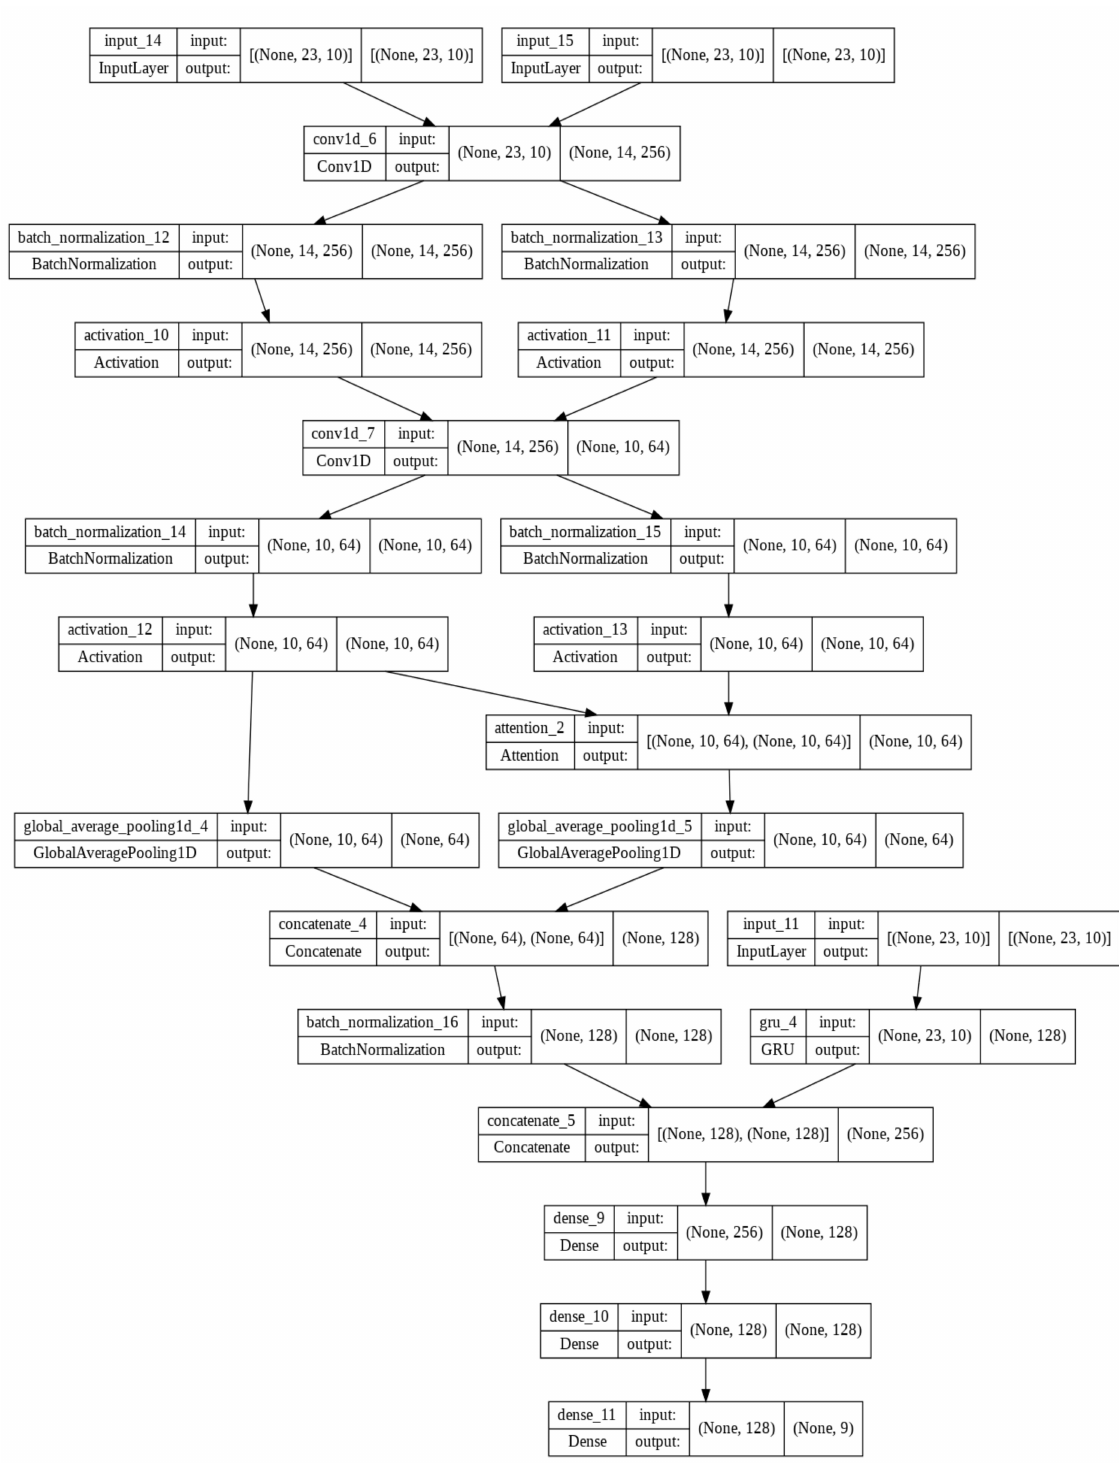
Figure A5. Attention on GRU + temporal